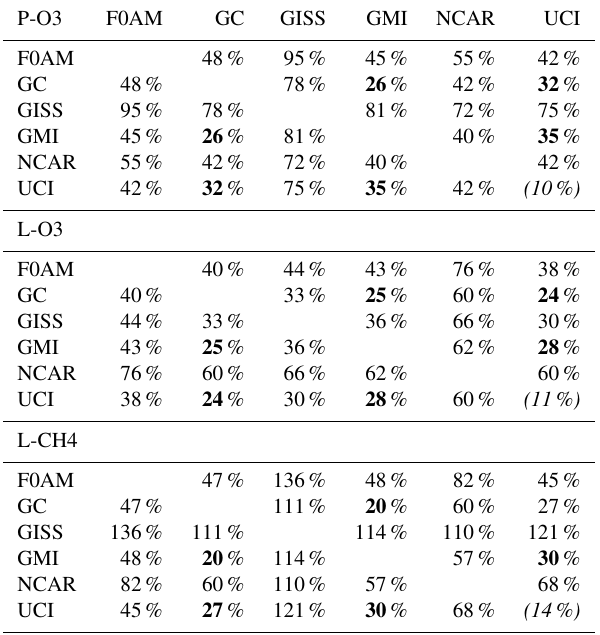
Table 3. Cross-model rms differences (RMSDs as a percentage of mean) for the three